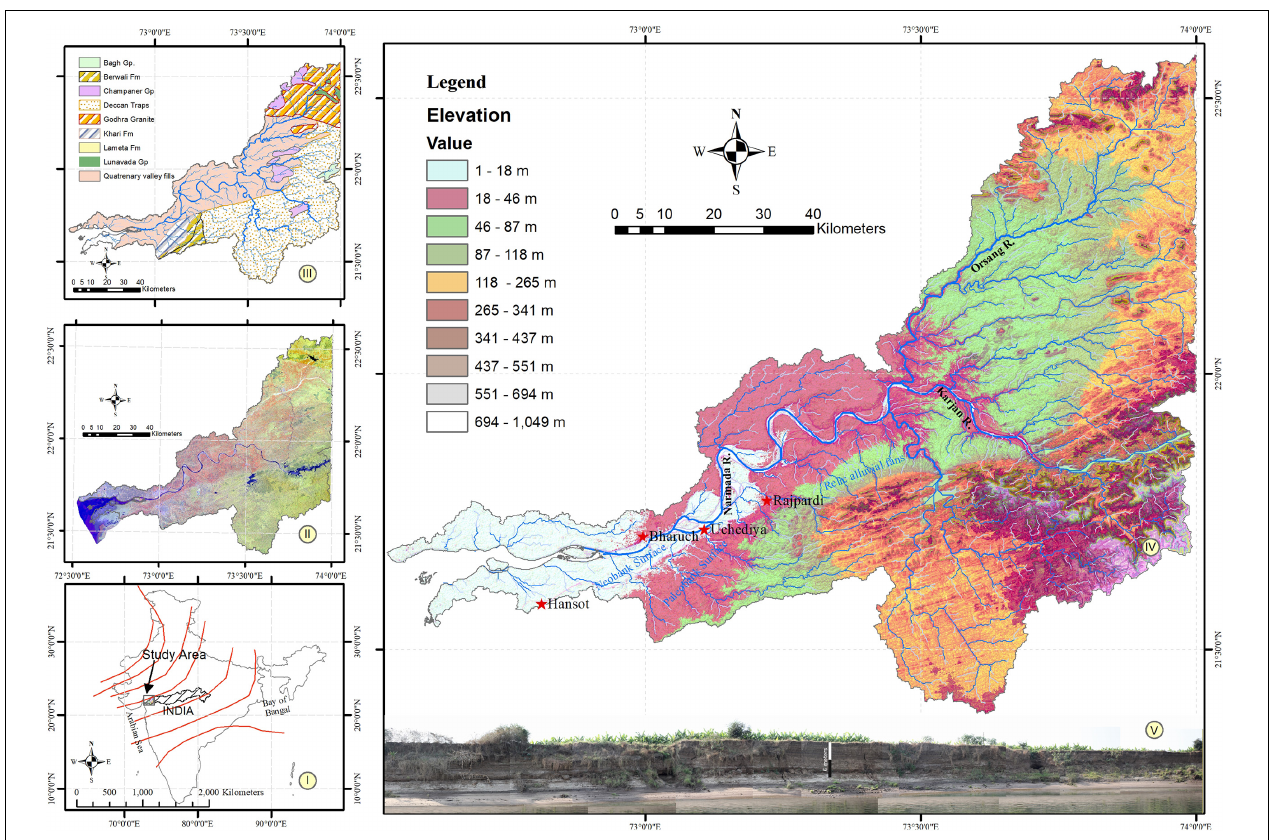
FIGURE 1 | (I) Index map of the study area showing normal withdrawal track (source: Indian Meteorological Department) of SW Indian monsoon (II) Landsat 8, false colour compost map of the study area with band composites Band 5 (NIR), Band 6 (SWIR-1) and Band 2 (Blue). (III) Geological map of the study area modified after the Geological Survey of India Geological map (https://bhukosh.gsi.gov.in/Bhukosh/MapViewer.aspx). (IV) Geomorphological map of the study area. Locations of important places mentioned in the text are marked. The neobank surface is bounded within the elevation of 1–18 m and the paleo-bank surface is bound between 18 and 46 m. Above 46 m the topography is produced by relict fanglomerates and upland rocks. (V) A regional view of the neobank